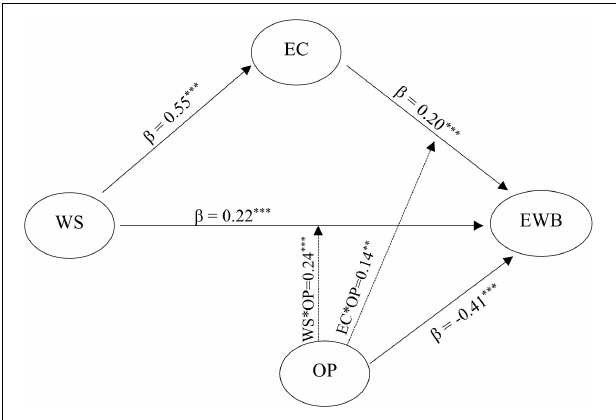
FIGURE 1 | Mediating effect of empathic concern between workplace spirituality and employee wellbeing as a function of organizational politics. Moderated mediation model (all coefficients are standardized). Here ∗∗ means p < 0.01 and ∗∗∗ means p < 0.001.